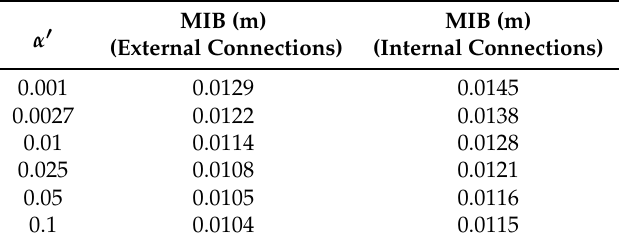
Table 6. MIBs for each α (cid:48) and for ˜ P CI =